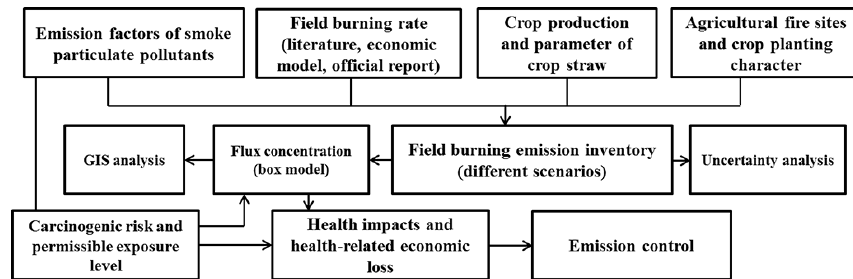
Figure 1. Schematic methodology for developing emission